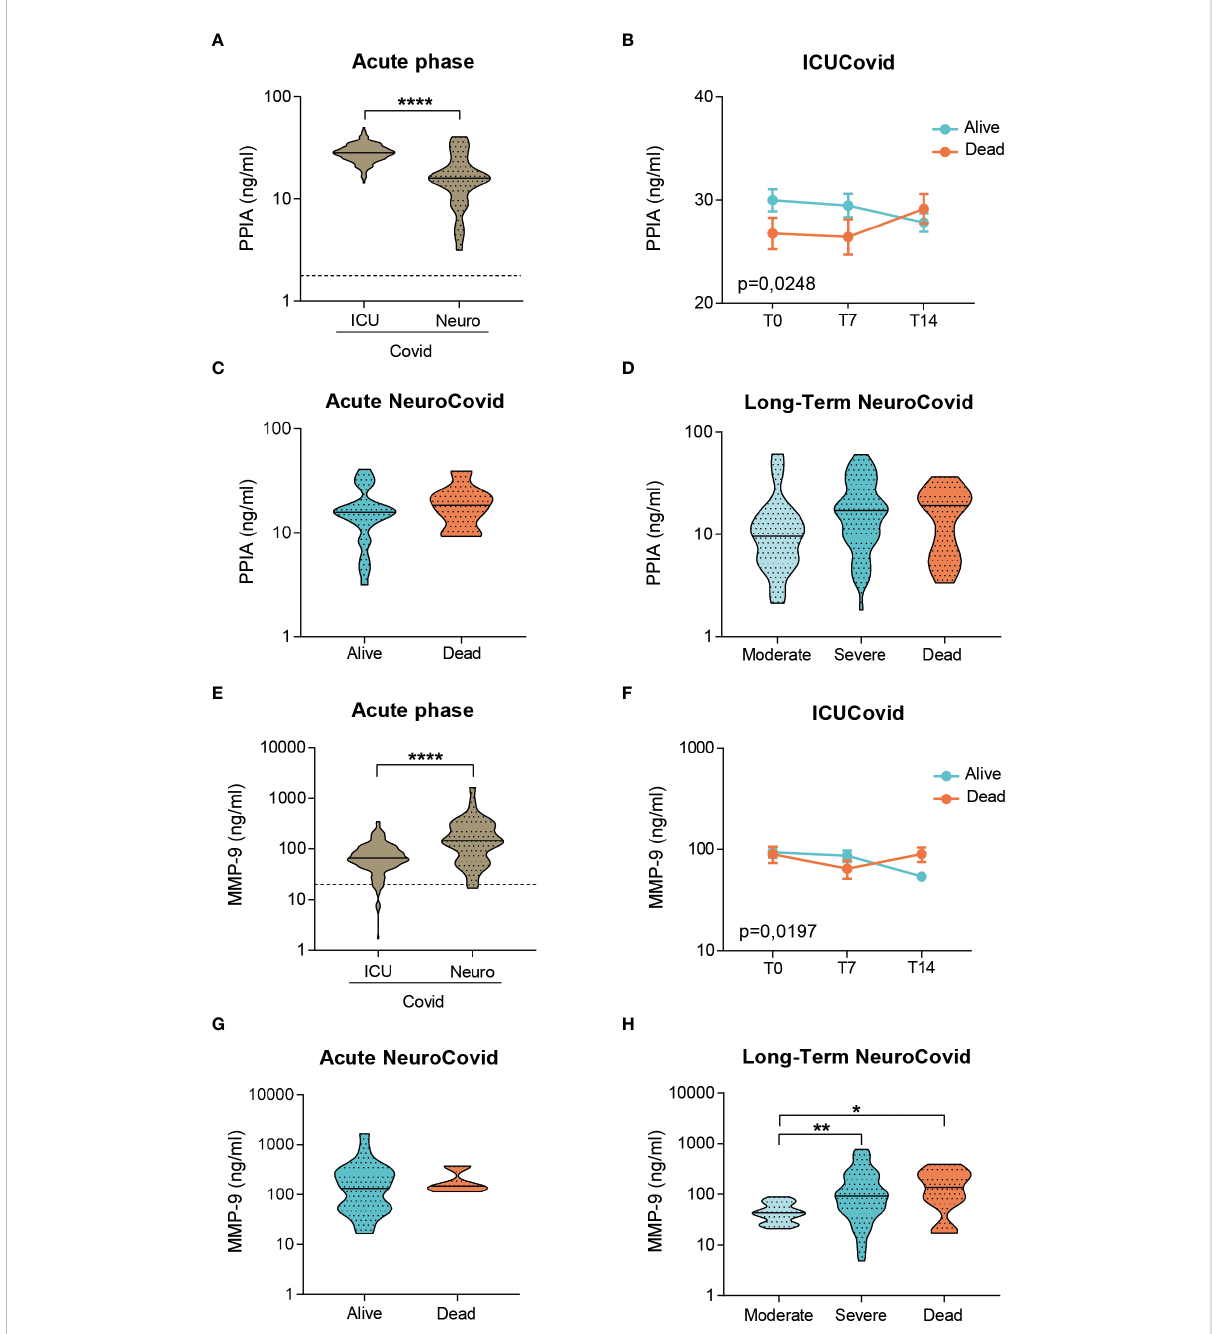
FIGURE 3 Analysis of PPIA and MMP-9 in plasma of two cohorts of COVID-19 patients. (A-H) PPIA (A-D) and MMP-9 (E-H) concentrations were measured respectively by ELISA and AlphaLISA technology in plasma samples from two cohorts of COVID-19 patients. (A, E) Violin plots indicate the median, variability and probability density of PPIA (A) and MMP-9 (E) at acute phase, in ICUCovid (n=79) and NeuroCovid samples (n=31). Dotted line indicates the mean level of healthy controls. (A, E) Mann Whitney, ****p< 0.0001. (B, F) The concentrations of PPIA (B) and MMP-9 (F) were measured in ICUCovid patients over time, at ICU admission (T0) and after 7 (T7) and 14 days (T14). ICUCovid patients were strati fi ed as alive (n=32) and dead (n=14). Data (mean ± SEM) indicate biomarker concentrations. (B) Two-way ANOVA for repeated measures, p=0.0248; (F) two-way ANOVA for repeated measures, p = 0.0197. (C, G) The concentrations of PPIA (C) and MMP-9 (G) were measured at acute phase, in samples from NeuroCovid patients, strati fi ed as alive (n=23) and dead (n=8). Violin plots indicate median, variability and probability density of biomarker concentrations. (C) Mann Whitney, p=0.3966; (G) Mann Whitney, p=0.5498. (D, H) The concentrations of PPIA (D) and MMP-9 (H) in the long-term, in samples from NeuroCovid patients, strati fi ed as moderate (n=18), severe (n=42) and dead (n=8). Violin plots indicate median, variability and probability density of biomarker concentrations. (D) Kruskal-Wallis, p= 0.1175. (H) Kruskal-Wallis, p=0.0048; *p < 0.05, **p < 0.01 by Kruskal-Wallis, Dunn ’ s post hoc